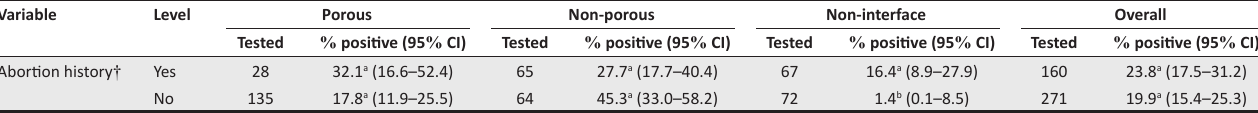
TABLE 2: Distribution of chlamydiosis seroprevalence in female goats according to abortion history.